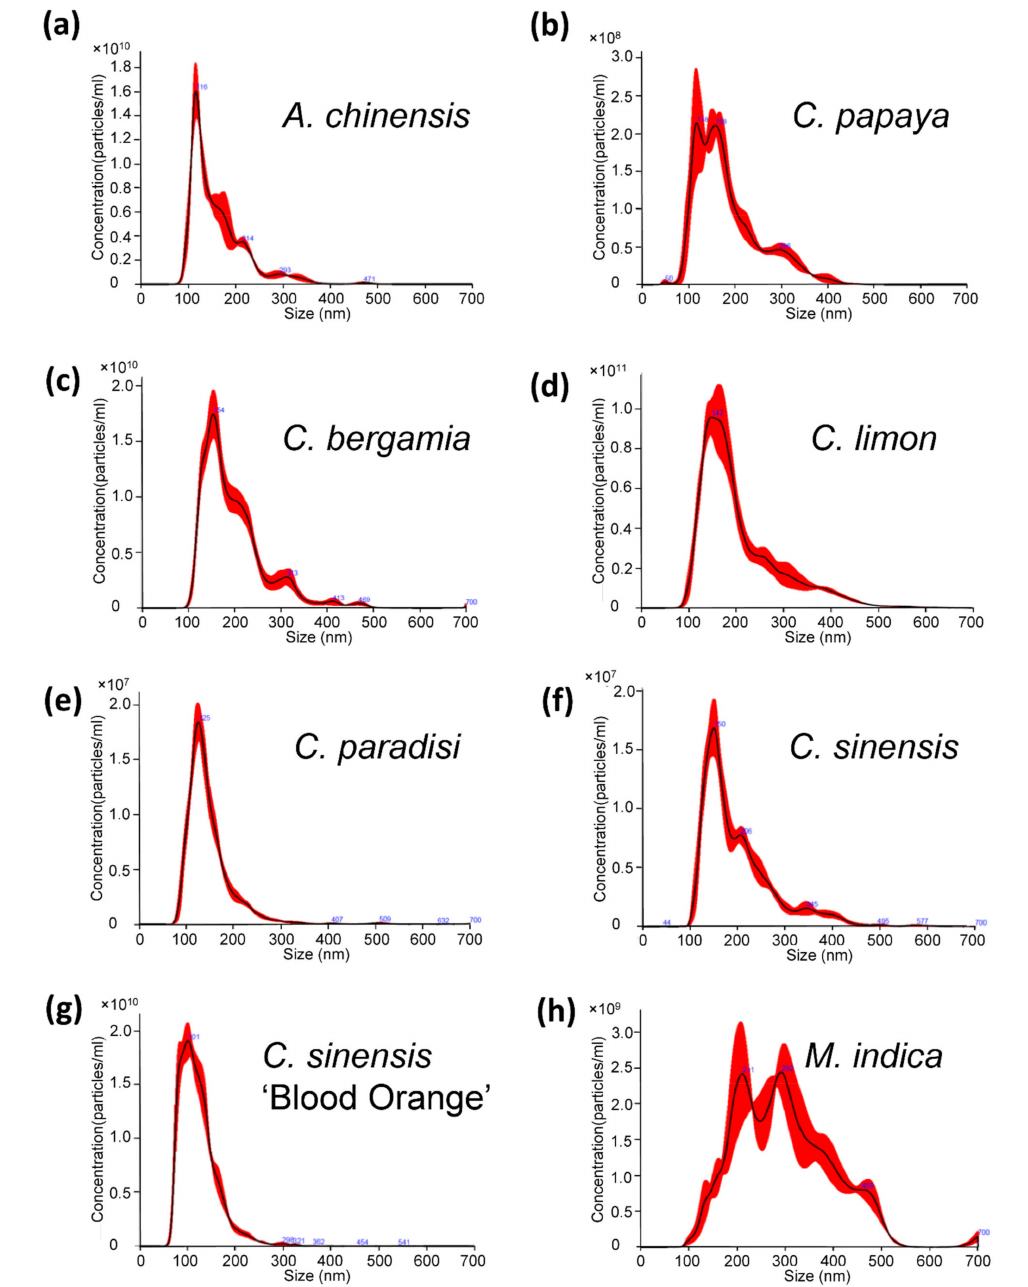
Figure 3. Distribution of organic agriculture-derived nanovesicles analyzed through NTA: ( a ) distribution of the nanovesicles isolated from kiwi ( A. chinensis ); ( b ) distribution of the nanovesicles isolated from papaya ( C. papaya ); ( c ) distribution of the nanovesicles isolated from bergamot ( C. bergamia ); ( d ) distribution of the nanovesicles isolated from lemon ( C. limon ); ( e ) distribution of the nanovesicles isolated from grapefruit ( C. paradisi ); ( f ) distribution of the nanovesicles isolated from orange ( C. sinensis ); ( g ) distribution of the nanovesicles isolated from blood orange ( C. sinensis ‘Blood Orange’); ( h ) distribution of the nanovesicles isolated from mango ( M. indica